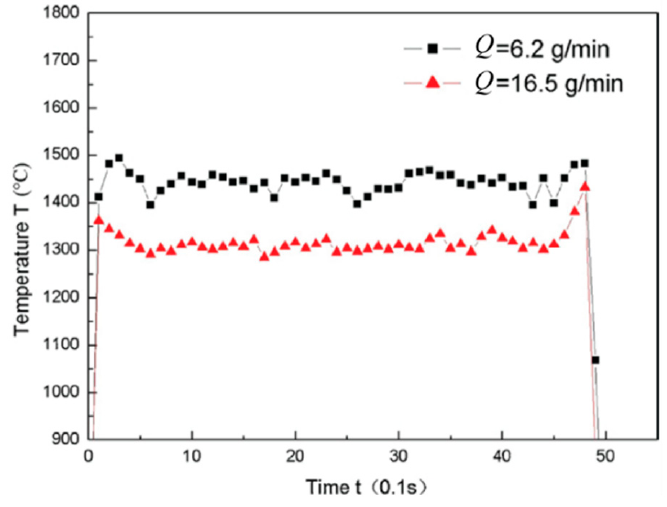
Figure 20. Effect of powder flow rate on temperature measurements using thermal monitoring (reproduced with permission from [97]; Copyright © 2008 Elsevier).